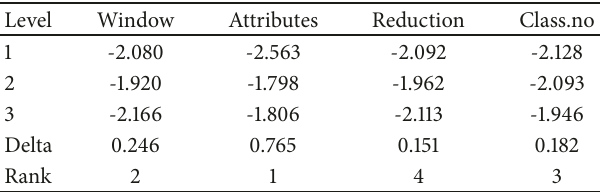
Table 6: Response Table for signal-to-noise ratios: Sea dataset.